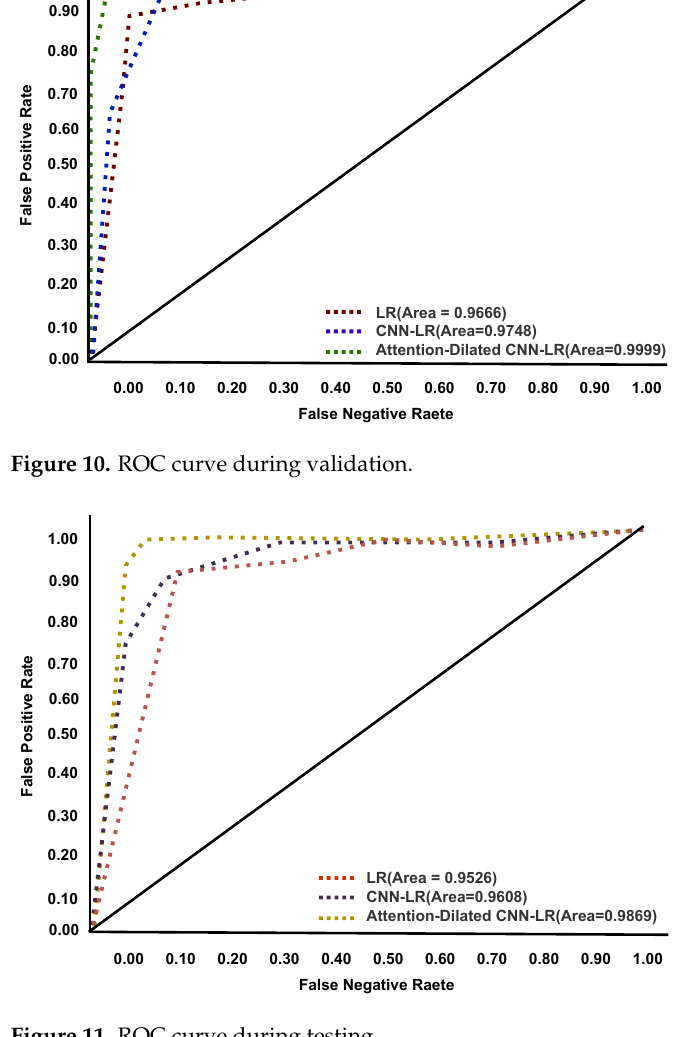
Figure 11. ROC curve during